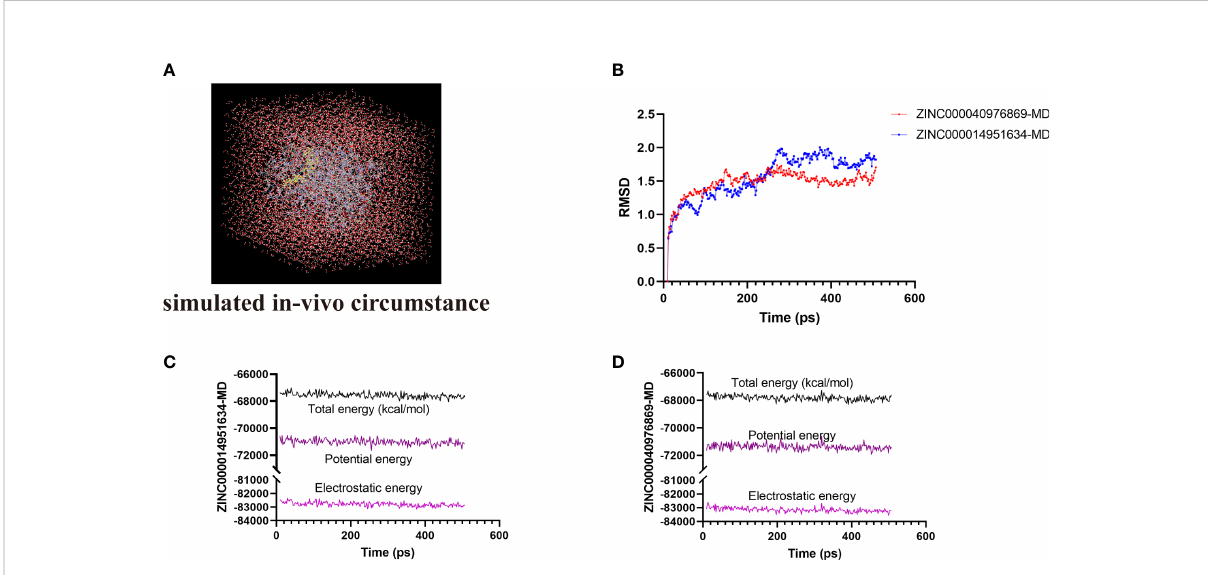
FIGURE 6 (A) Orthorhombic box with an explicit periodic boundary solvation water model. (B) Average backbone root mean square deviation (RMSD) of these two ligand – MAPKAPK2 complexes. (C, D) Different kinds of energy values of ZINC000014951634 – MAPKAPK2 and ZINC000040976869 – MAPKAPK2 complexes during molecular dynamics